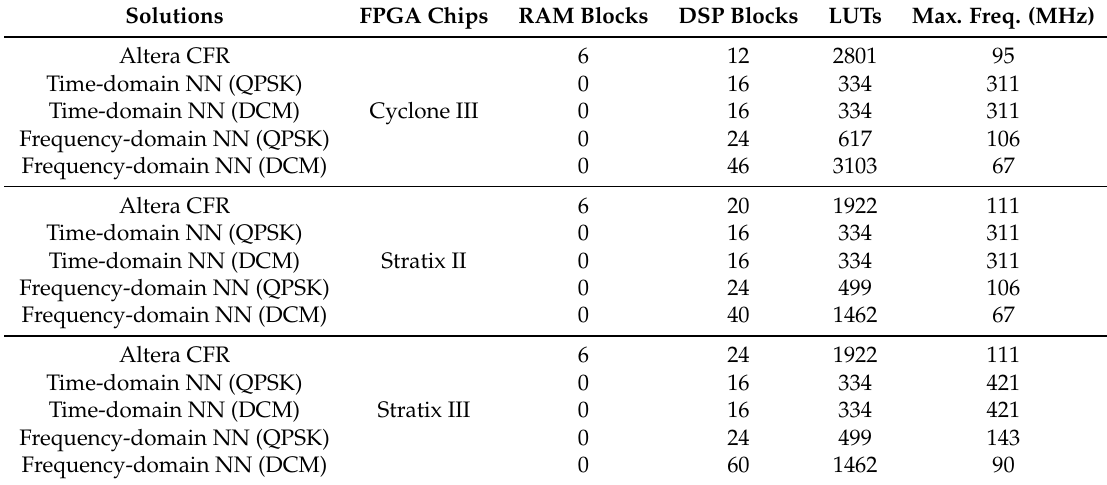
Table 6. Resource consumption in the case of Altera